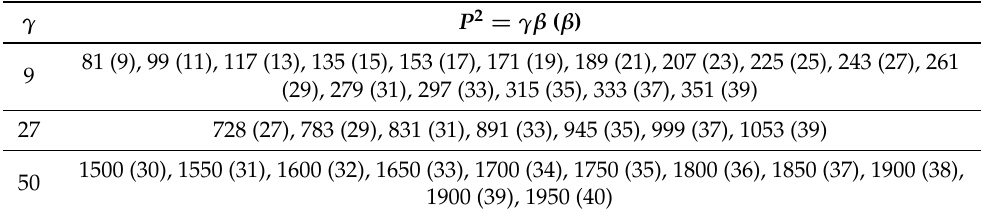
Table 4. Additional γ and β values taken into account in simulation.